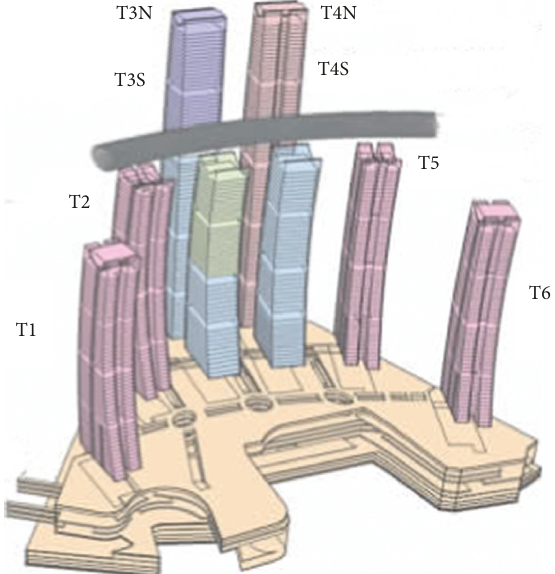
Figure 2: The layout of the